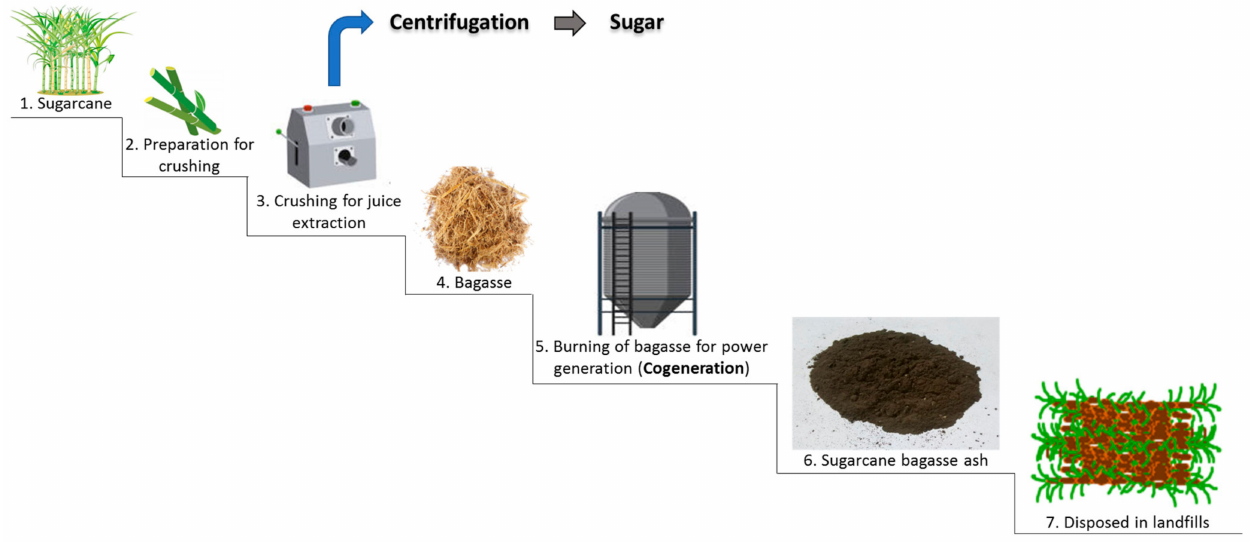
Figure 1. Steps of sugarcane bagasse ash production.